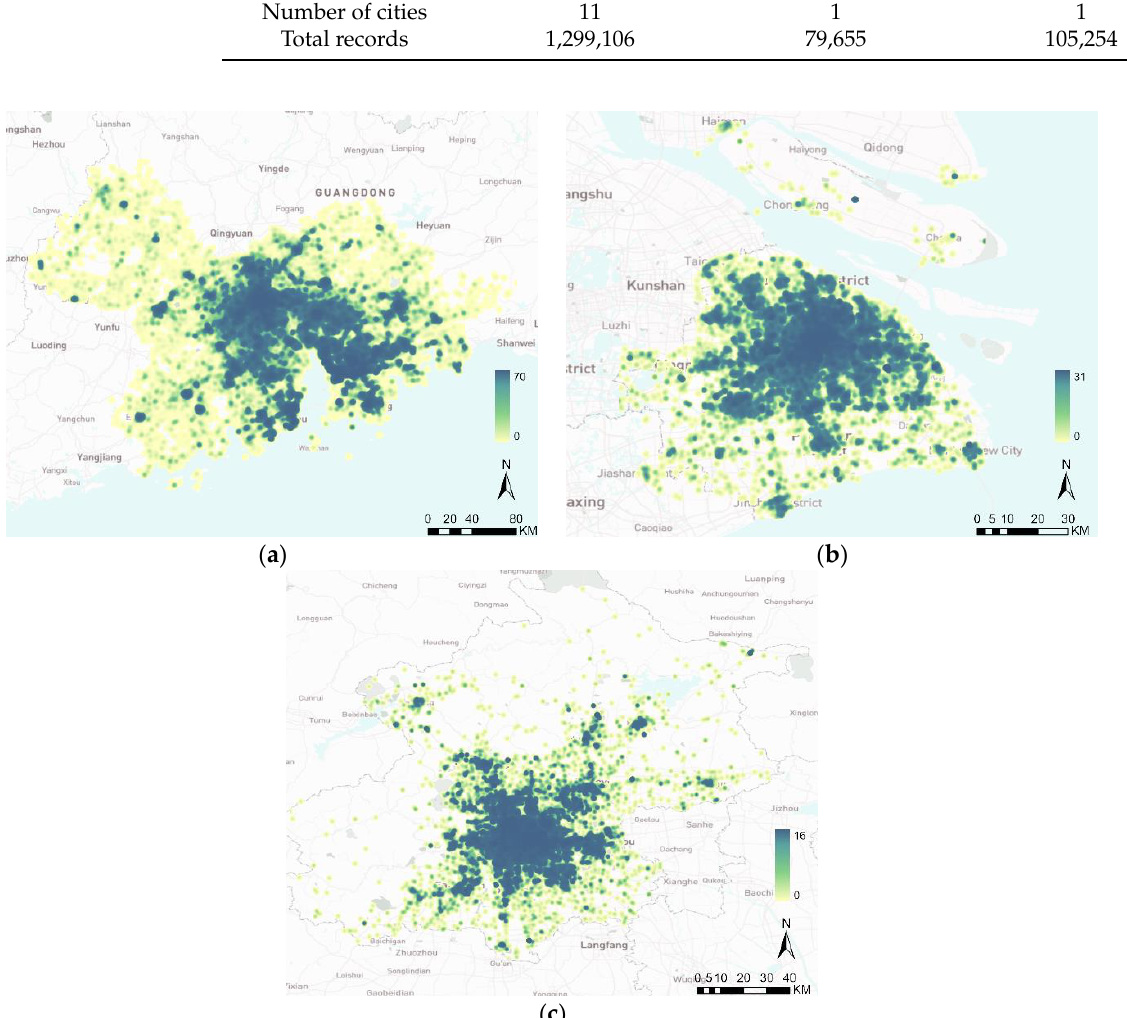
Figure 1. Heatmaps of the three datasets, namely ( a ) GBA dataset, ( b ) Shanghai dataset, and ( c ) Beijing dataset. The color depth indicates the density, with areas with deep color having high densities.